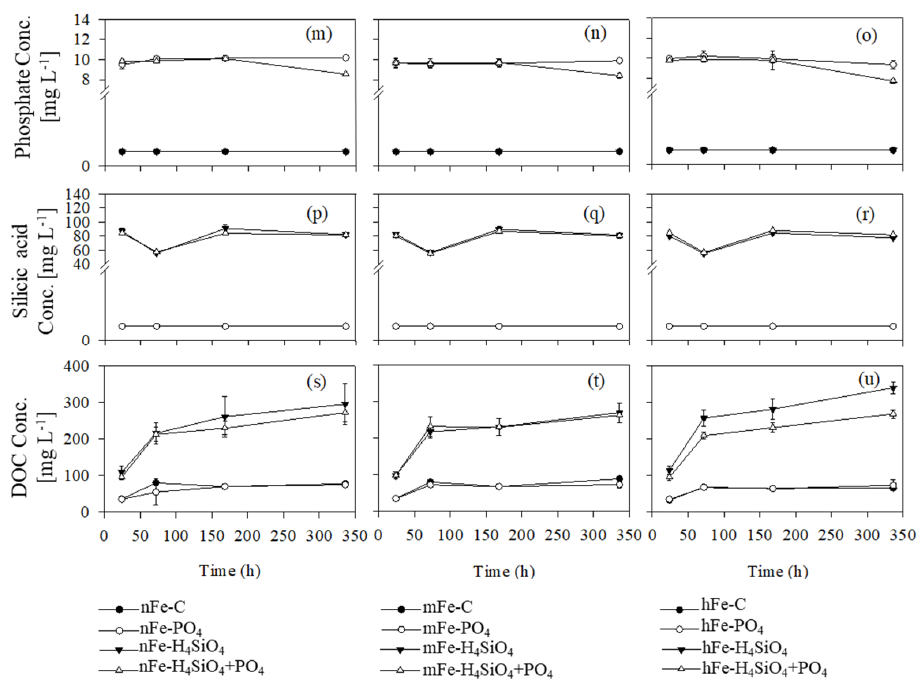
Figure 3. The concentration of phosphate: PO 4 ( m – o ); silicic acid: H 4 SiO 4 ( p – r ); and dissolved organic carbon: DOC ( s – u ) versus time during anoxic conditions. Data represent the mean; whiskers represent the standard deviation ( n = 3). Goethite: Fe; no Fe: nFe; medium Fe: mFe; and high Fe: hFe.